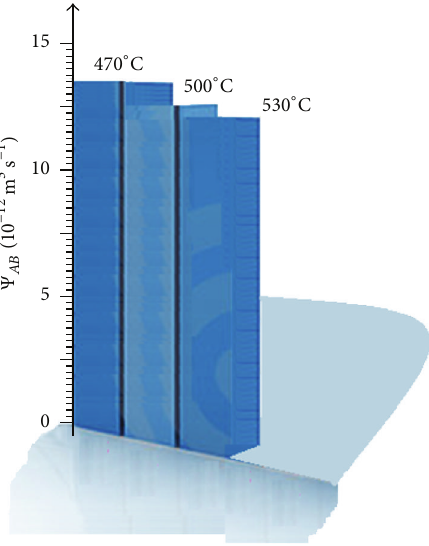
Figure 4: Values of the Amlouk-Boubaker optothermal expansivity ∘ C, 500 ∘ C and 530 ∘ C). Ψ 𝐴𝐵 for iron telluride films (470